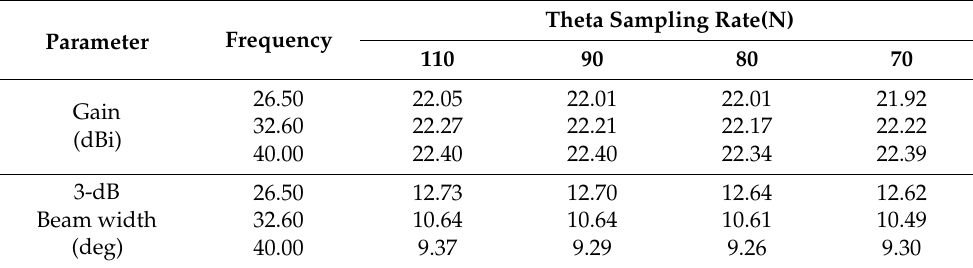
Table 5. Comparison of the measured gain and 3 dB beam width of a horn antenna.